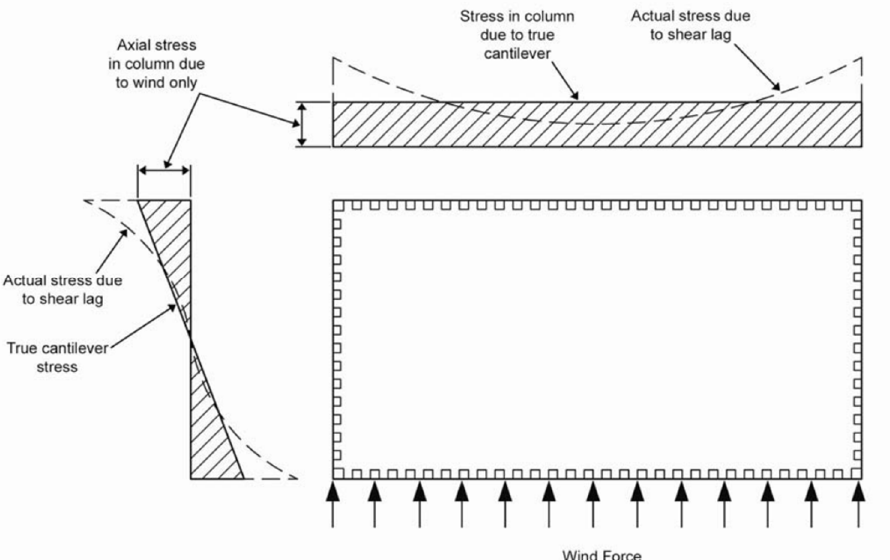
Figure 7. Shear lag. (Source: [5], p. 45).